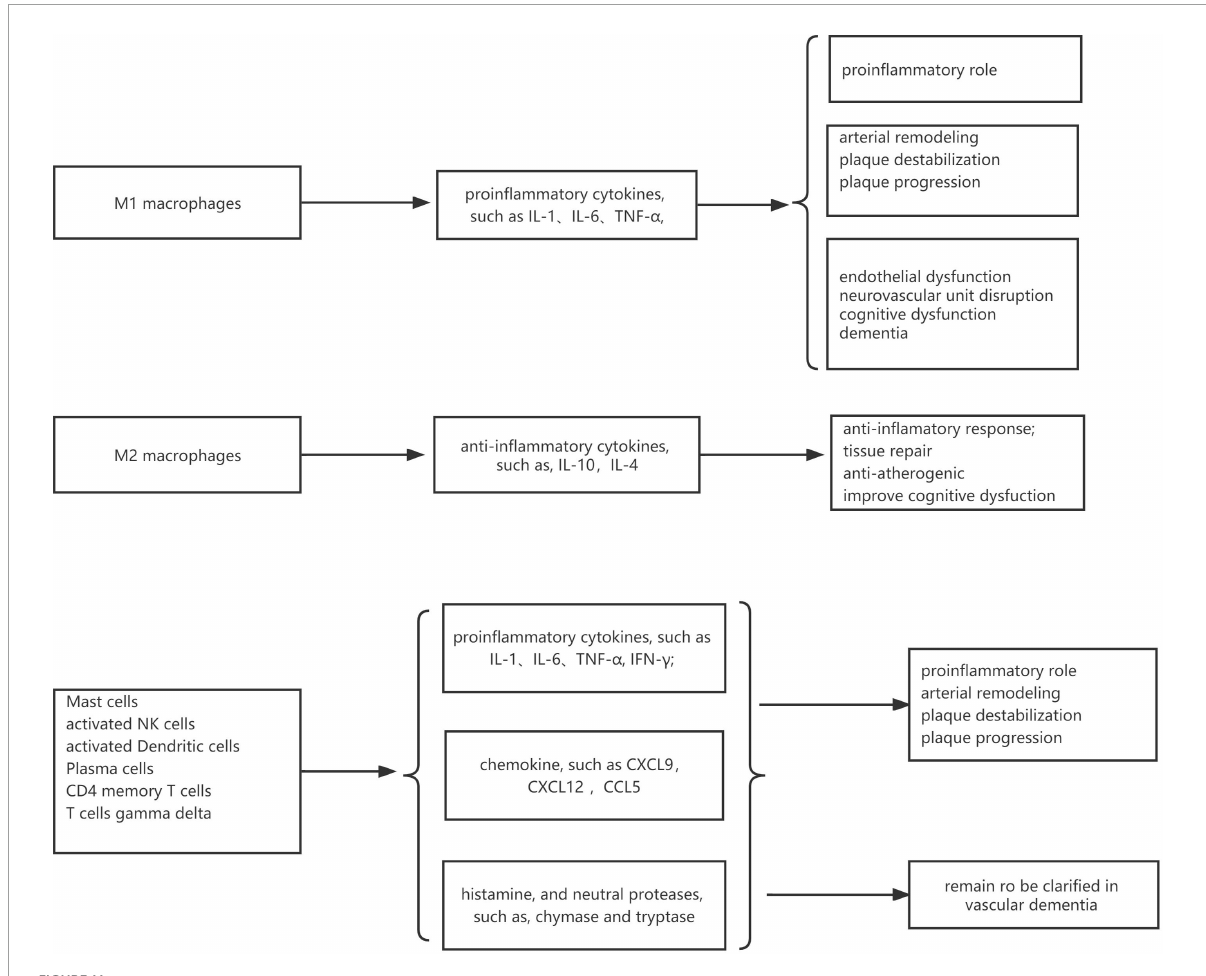
FIGURE11 The association between inflammation pathways and the immune system as well as the development of vascular dementia and carotid plaque.